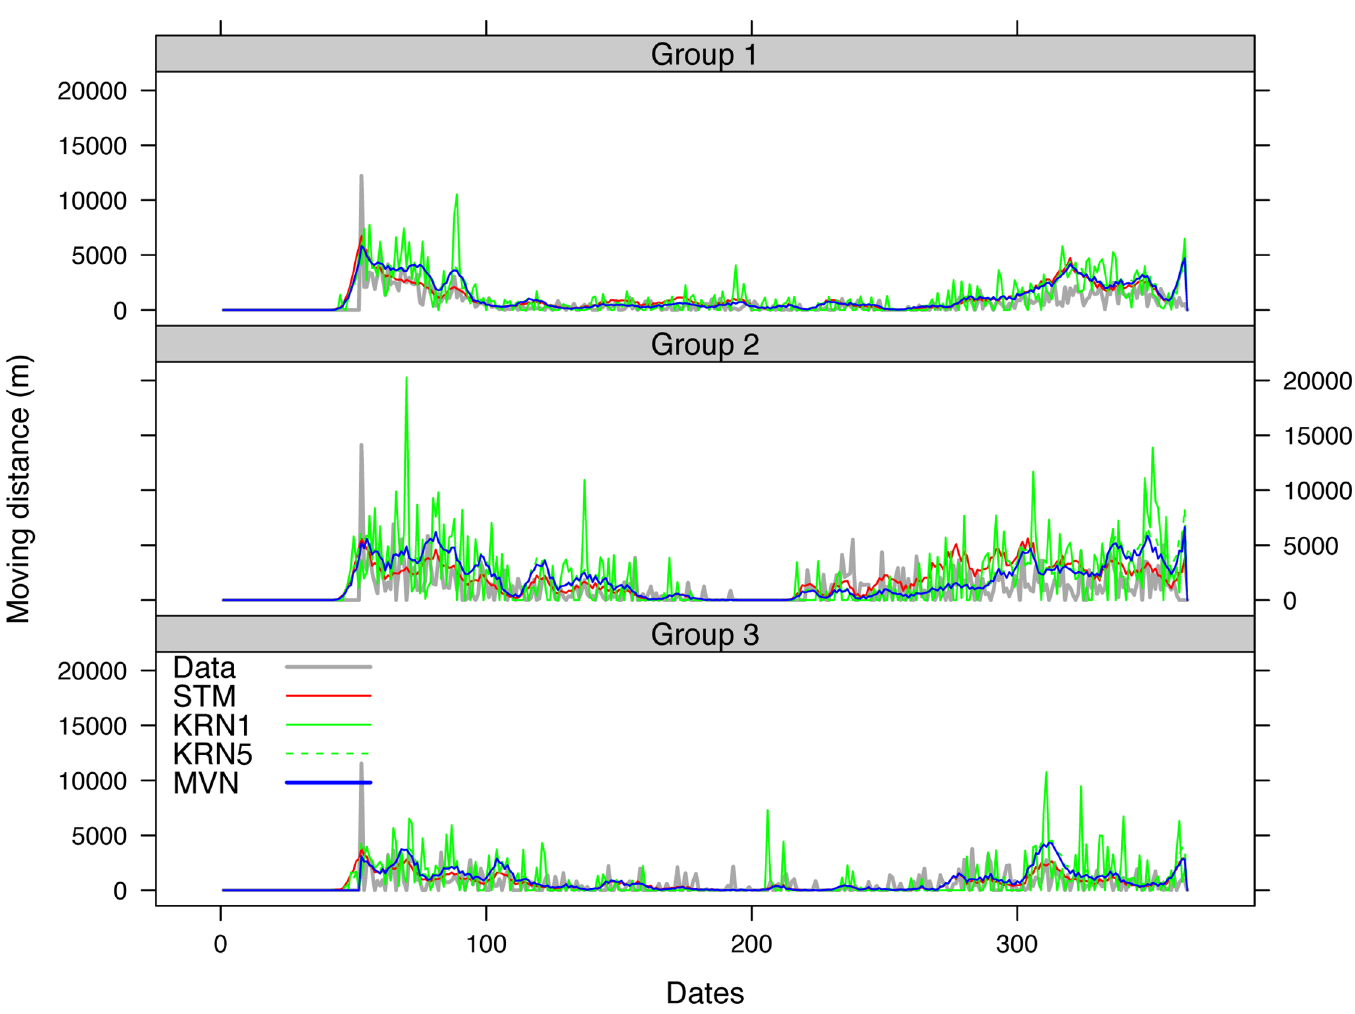
Fig 12. Daily mean moving distance obtained from the 2007 – 2008 data and 100 simulations using STM, KRN, and